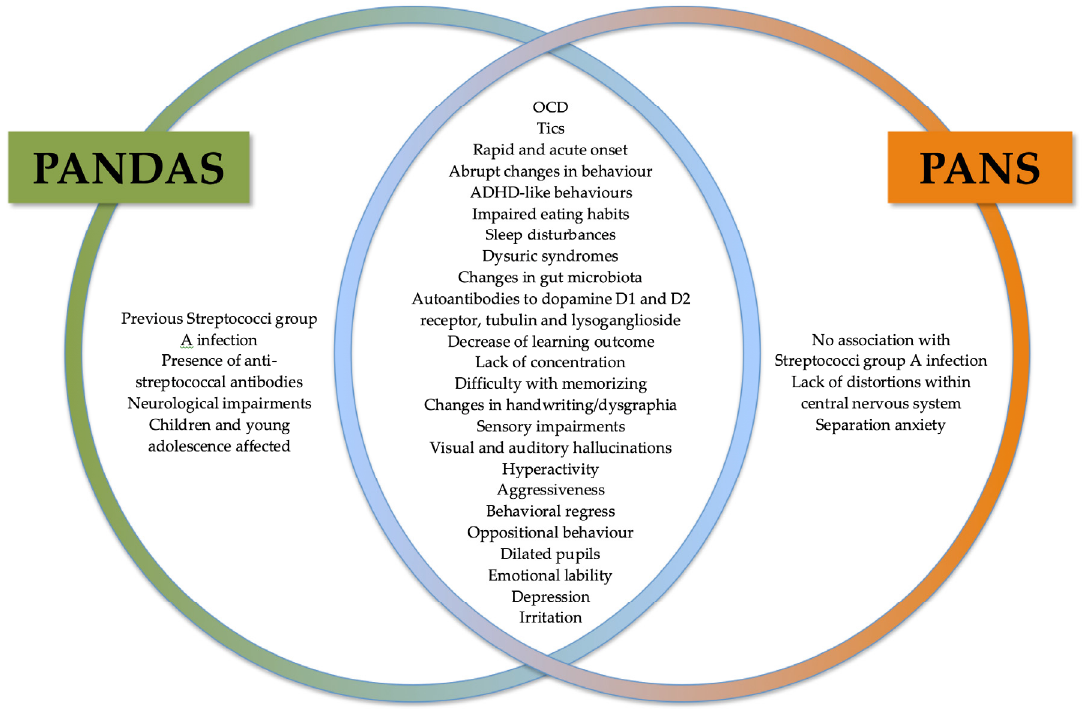
Figure 1. Common and distinct symptoms characteristic to PANDAS and PANS.